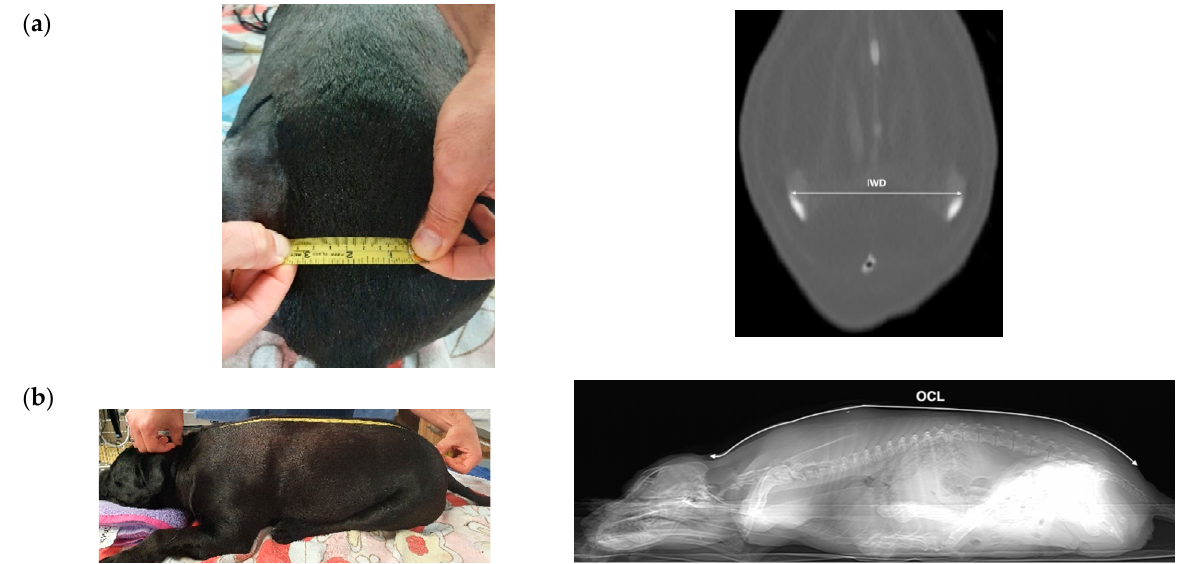
Figure 1. Representative measurements of ( a ) ilium wing distance (IWD), and ( b ) occipital-coccygeal length (OCL) obtained by surface measurements on a dog cadaver (left) and in the same dog on CT (right). Bi-directional arrows depict the landmark sites of the computed tomography (CT) images with the IWD measuring the distance between the dorsal aspects of the ilium wings on the dorsal plane window where both bony structures were first clearly visible, and the OCL from the occipital protuberance to the median sacral crest of the first sacral vertebrae following the dorsal midline of the image from the scout view.